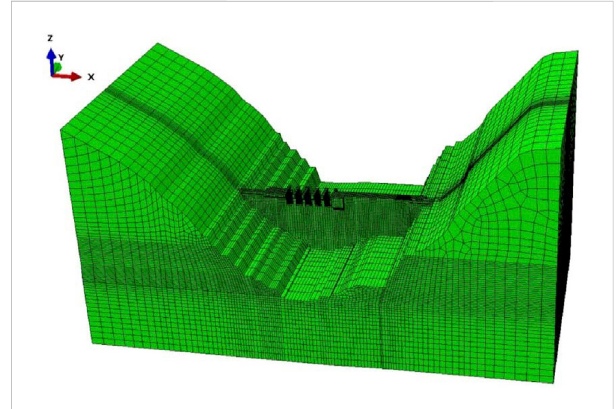
FIGURE 5 Adamnumericalmodelforestablishingstaticbehaviorsurrogate model.